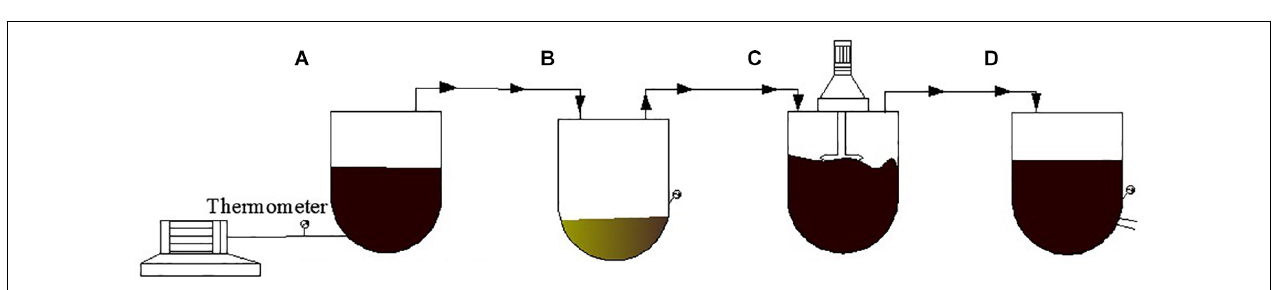
FIGURE 1 | Experimental microphotographs plan for the recovered bitumen tests.